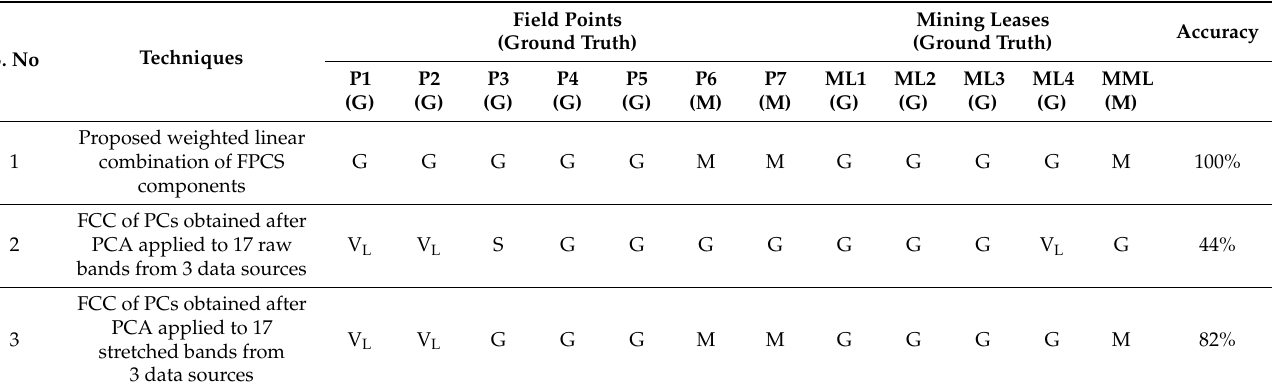
Table 5. Validation of results after they were compared with known locations of granite Leases (locations ML-1–ML-4, MMLs, and field survey points P1–P7 in Figure 2 of Shewa Shahbazghari and Ambela complexes.